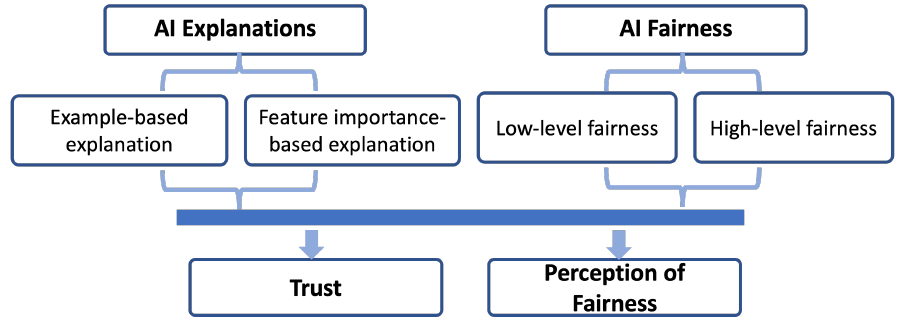
Figure 1. Effects of AI explanation and fairness on user trust and perception of